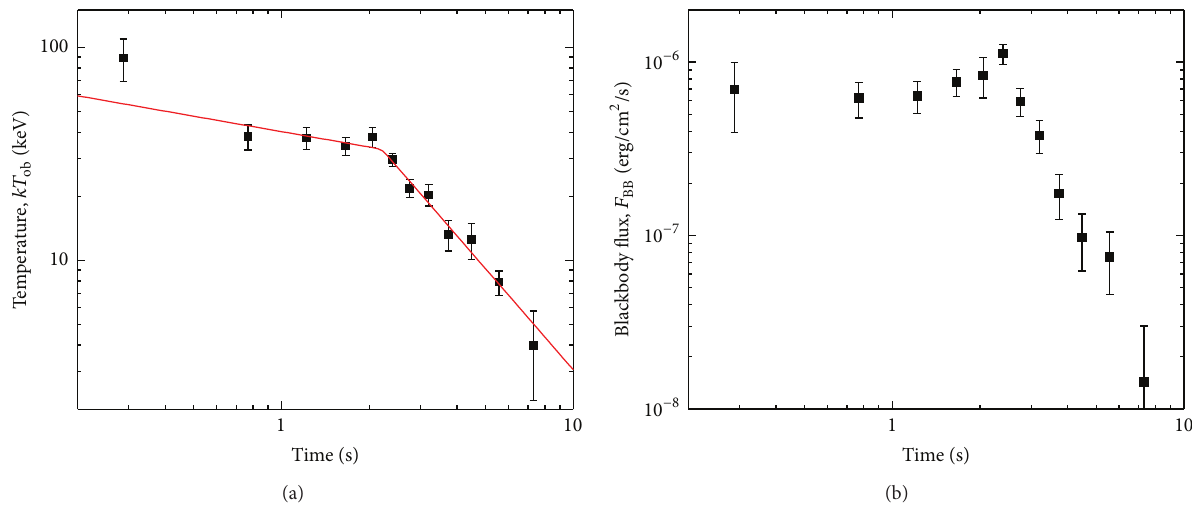
Figure 9: (a) The temperature of the thermal component of GRB110721A at different time bins shows a clear “broken power law” with ∼ 3 s, and 𝑇(𝑡) ∼ 𝑡 − 0 . 67 at later times. (b) The flux of the thermal component shows a similar broken power law 𝑇(𝑡) ∼ 𝑡 − 0 . 25 before 𝑡 brk temporal behavior, with similar break time. At late times, 𝐹 BB (𝑡) ∝ 𝑡 − 2 . See Ryde and Pe’er [89] for details. Figure courtesy of Ryde.